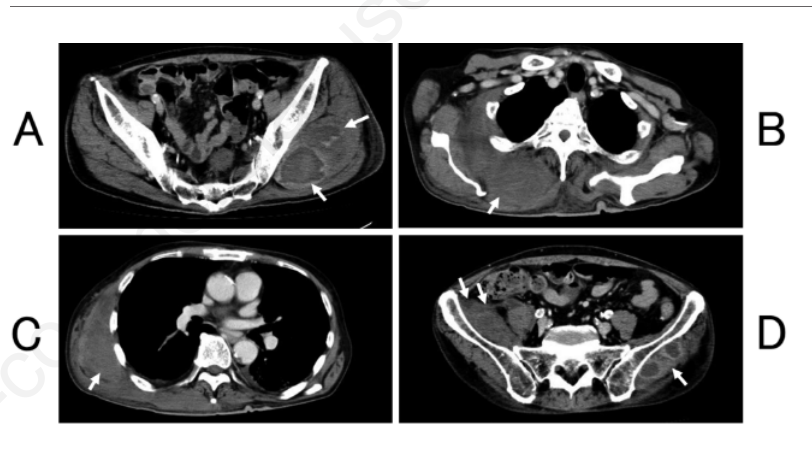
Figure 2. Intramuscular hemorrhage on CT (white arrow). A) Left middle gluteal muscle; B) right trapezius muscle; C) right latissimus dorsi muscle; D) right iliac muscle (intra- muscular hemorrhage of the left middle gluteal muscle was also observed).